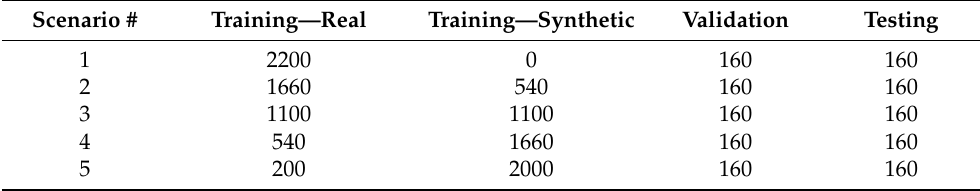
Table 2. Composition of training, validation and testing dataset for each training